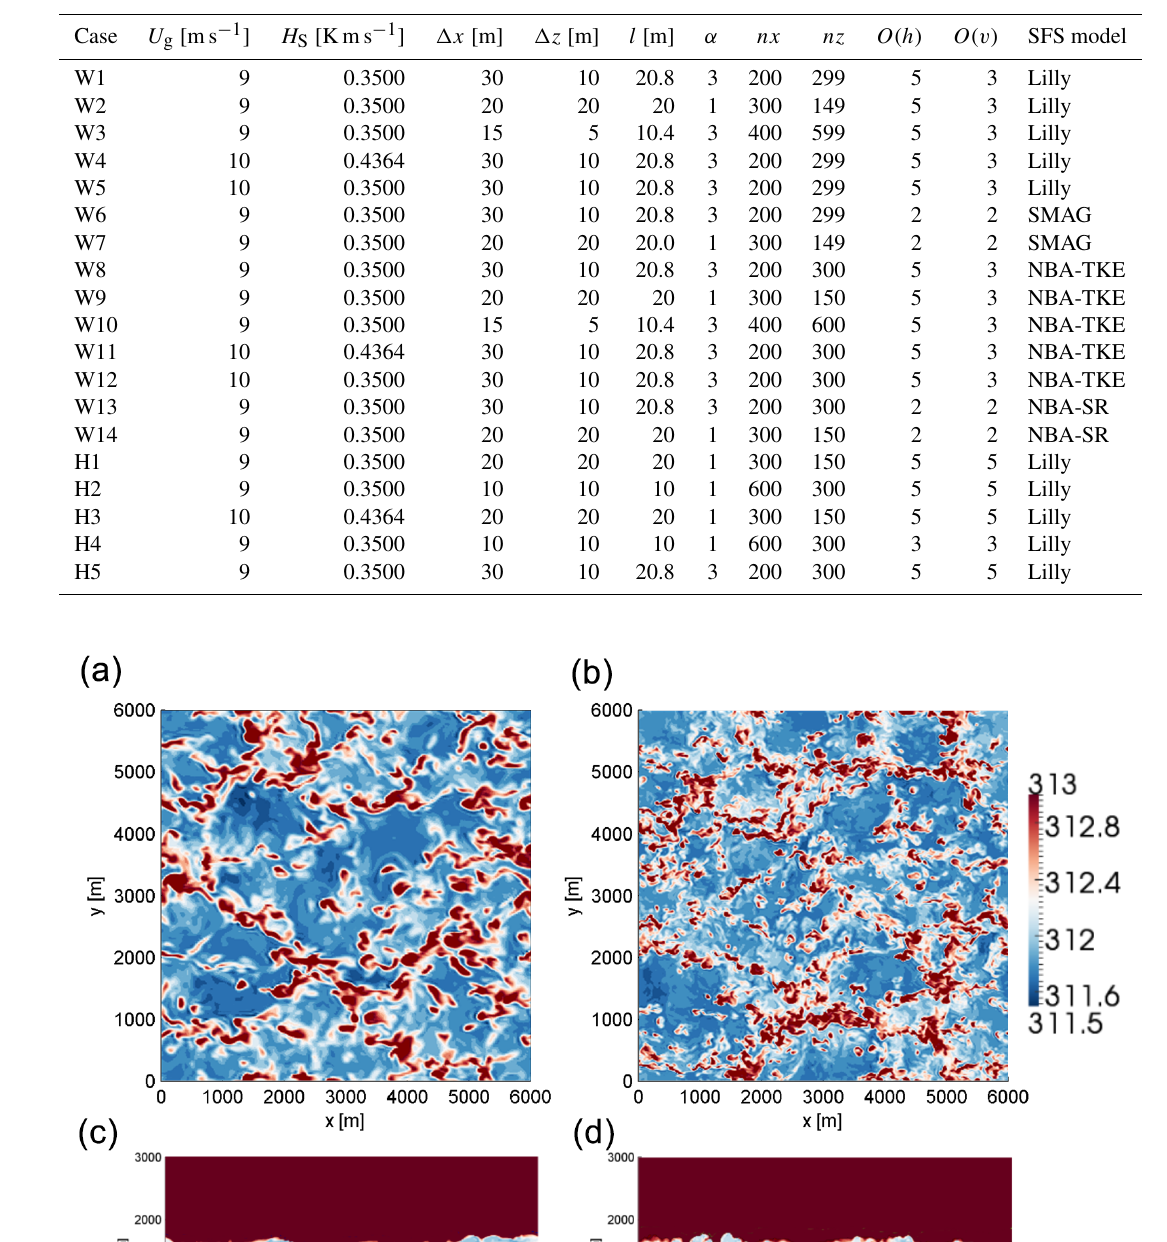
Table 2. Forcing and configuration parameters for the convective-case sensitivity studies, using WRF (W), SOWFA (S), and HiGrad (H), as described in the text.